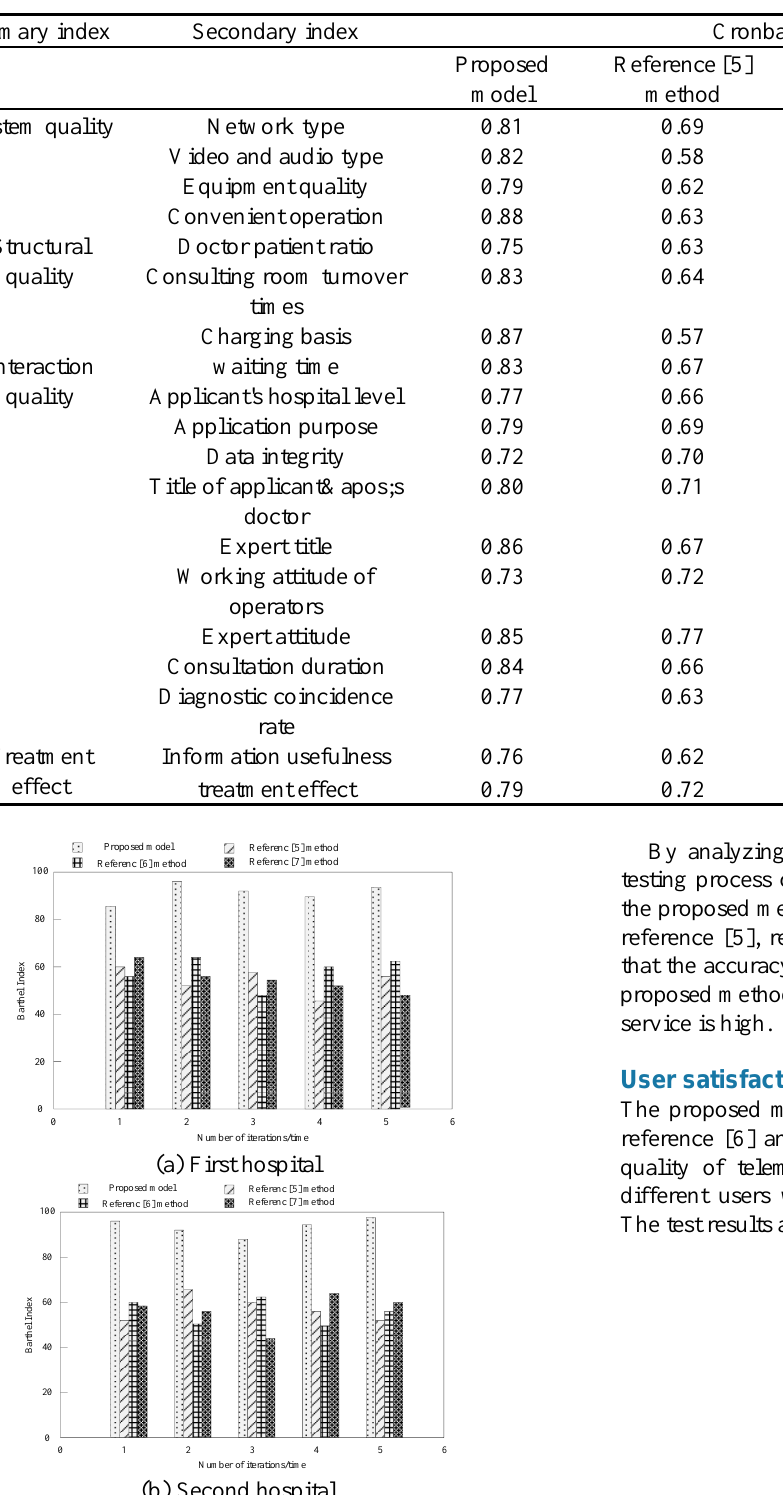
Table 1. Results of validity